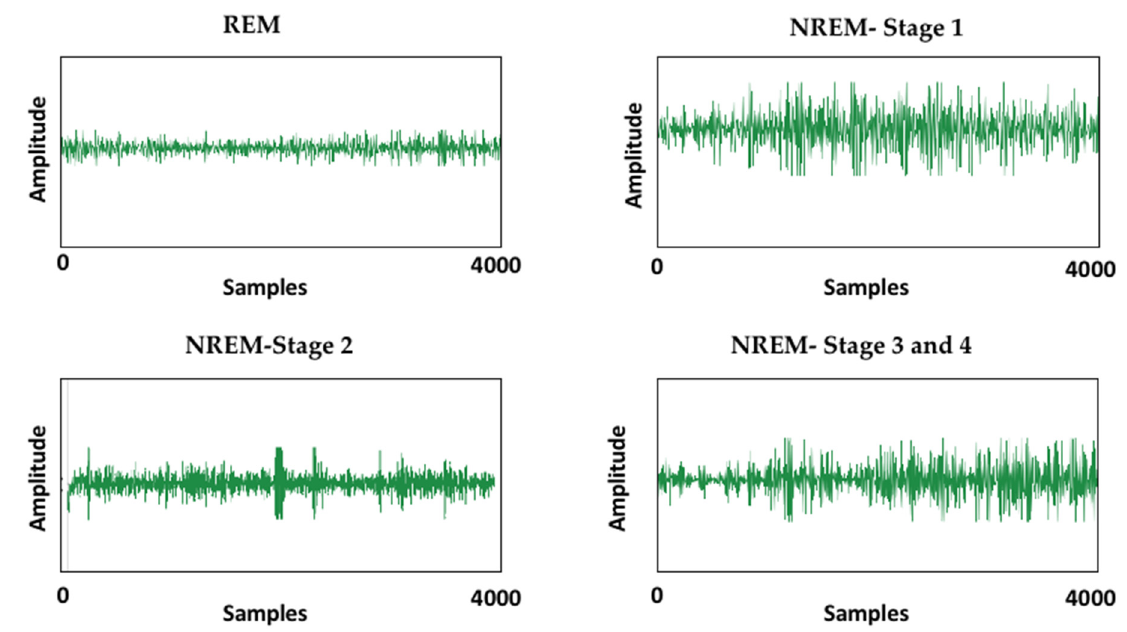
Figure 3. The EEG signals associated with the different sleep stages of a normal human being.